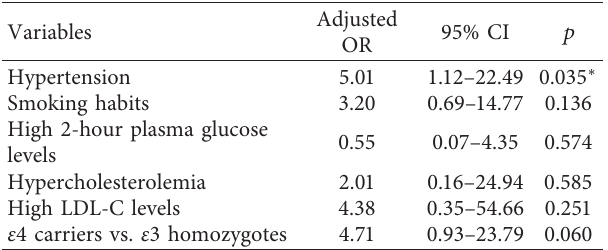
Table 5: Multivariate logistic regression of variables related to ischemic stroke in